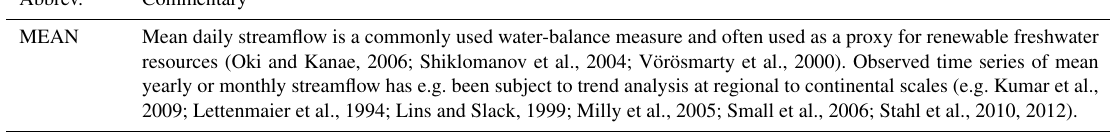
Table 4. Commentary and literature supporting the GSIM indices.